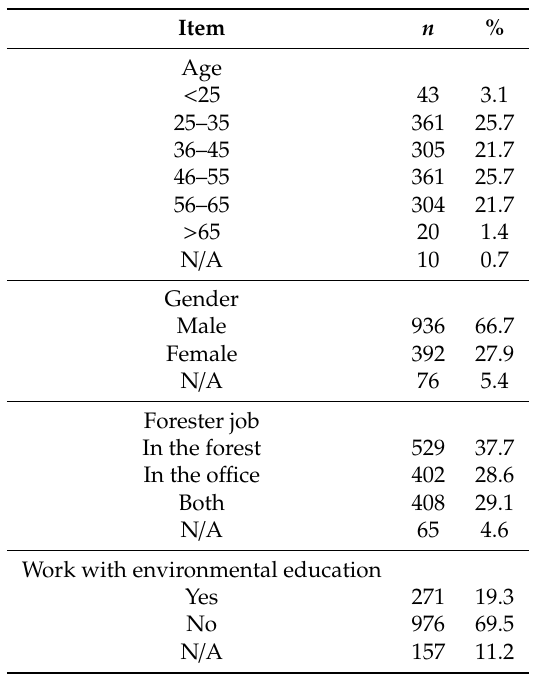
Table 4. Characterization of independent data based on survey responses, N / A—no